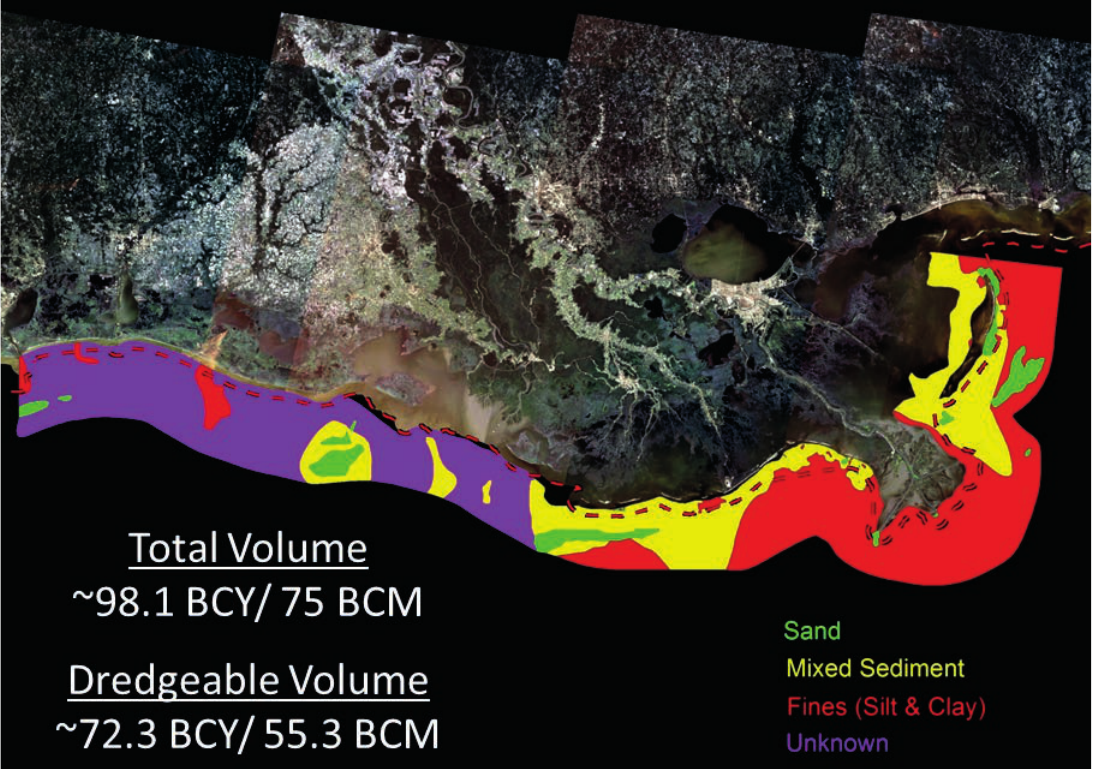
Fig. 2 First-order assessment of offshore Louisiana surficial sediment distribution and volume.